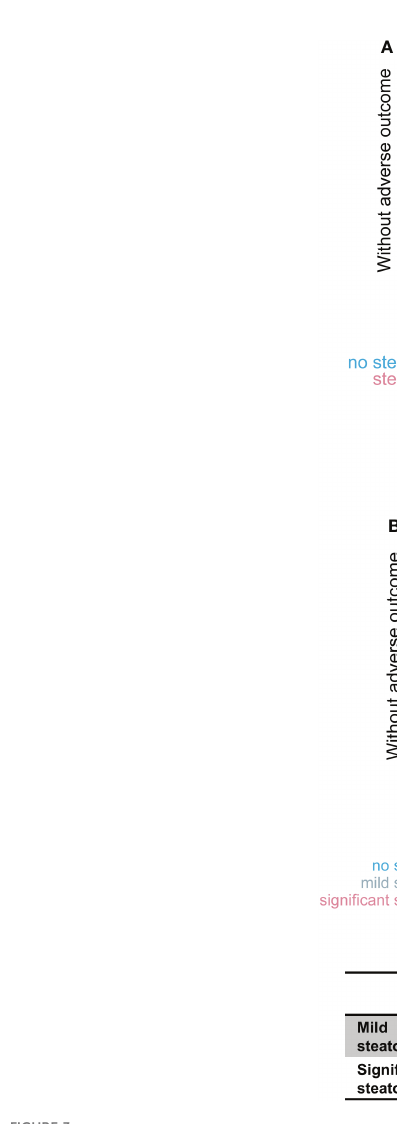
FIGURE 3 Kaplan ‐ Meier plots predict the association between the adverse outcome-free probability and hepatic steatosis. (A) Between patients with and without steatosis. (B) Strati fi ed analysis of different degrees of hepatic steatosis. Cumulative, AIH autoimmune hepatitis, HR hazard ratio, CI con fi dence